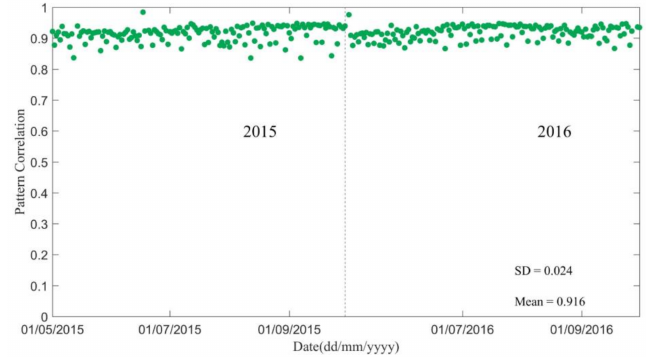
Figure 6. Time series of the daily spatial pattern correlation between the SMAP L3_SM_P_E